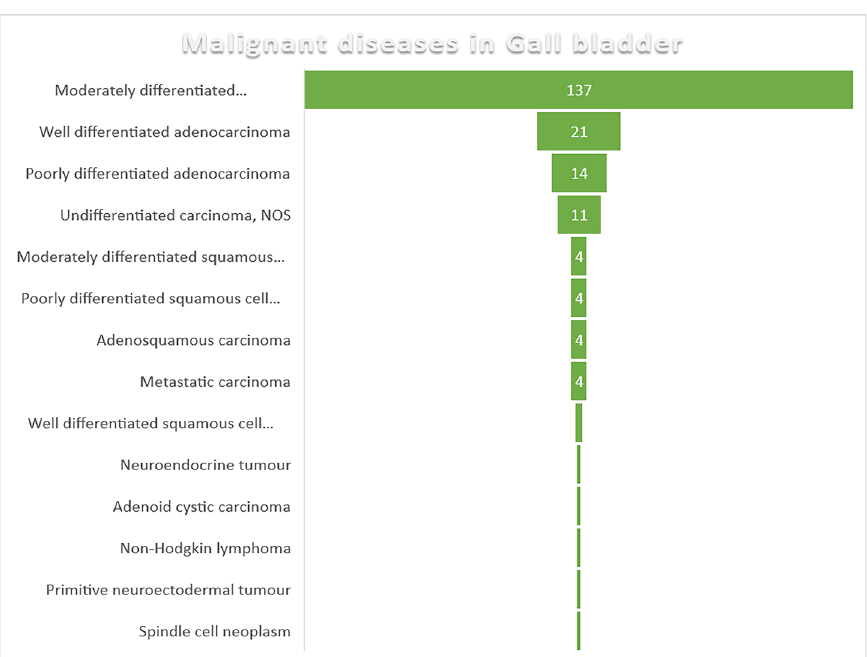
Figure 2. Chart showing the prevalence of malignant gall bladder diseases in North-Western India (Numbers represent absolute values)